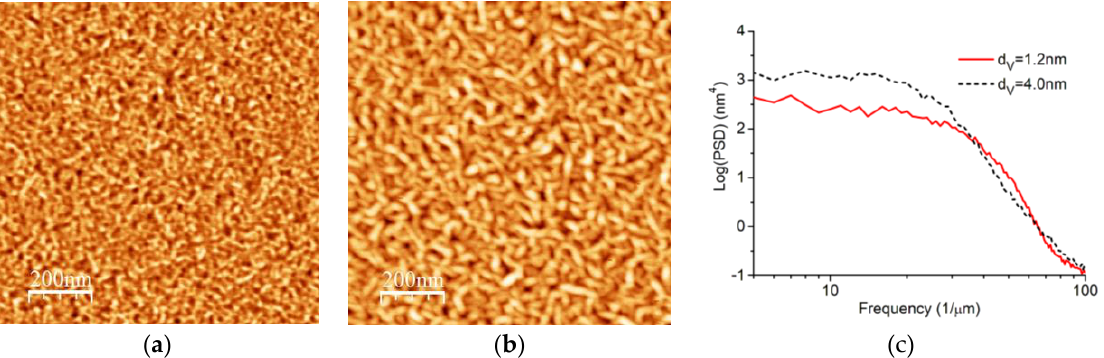
Figure 4. AFM images of the surface of Cr/V multilayers with different vanadium layer thickness: ( a ) d V = 1.2 nm and ( b ) d V = 4.0 nm. The PSD (Power Spectral Density) functions of the surface morphology of the two samples are shown in ( c ).